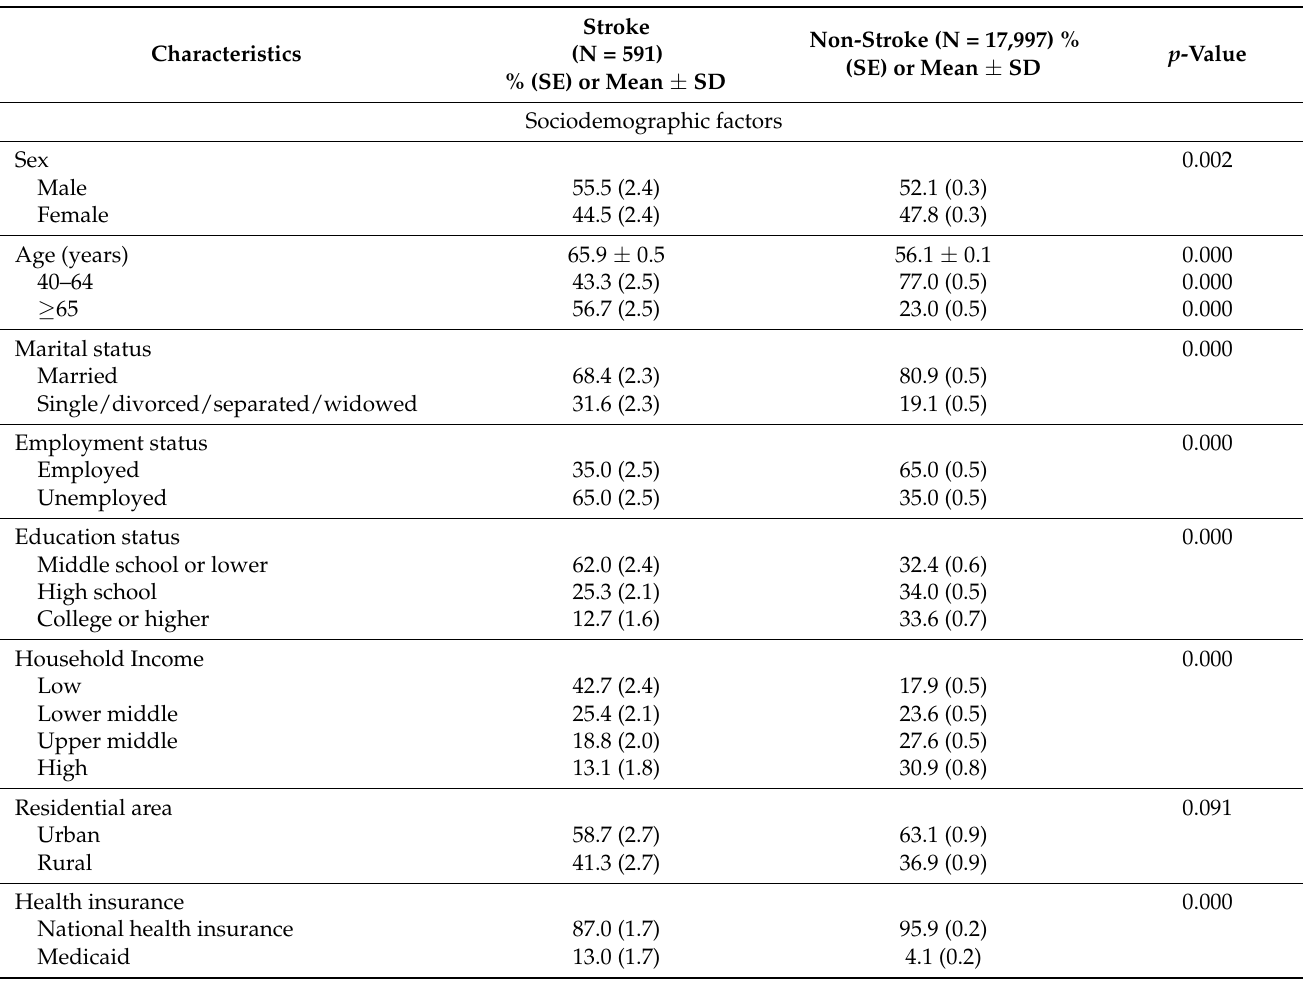
Table 1. Baseline characteristics of those with and without